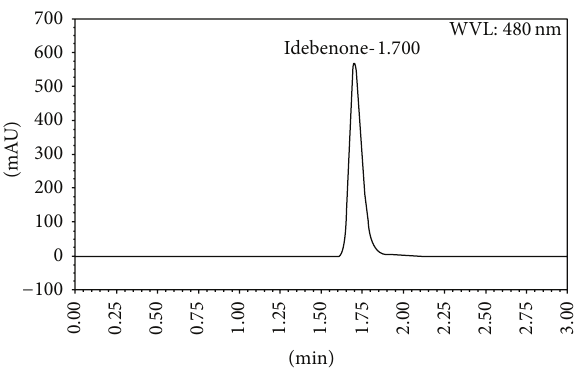
Figure 2: Representative HPLC chromatogram of idebenone stan- dard (4mg/mL) in methanol mobile phase; flow rate: 1.0mL/min; detection wavelength: 480nm; column temperature: 25 ± 3 ∘ C; and injection volume: 25 𝜇 L.